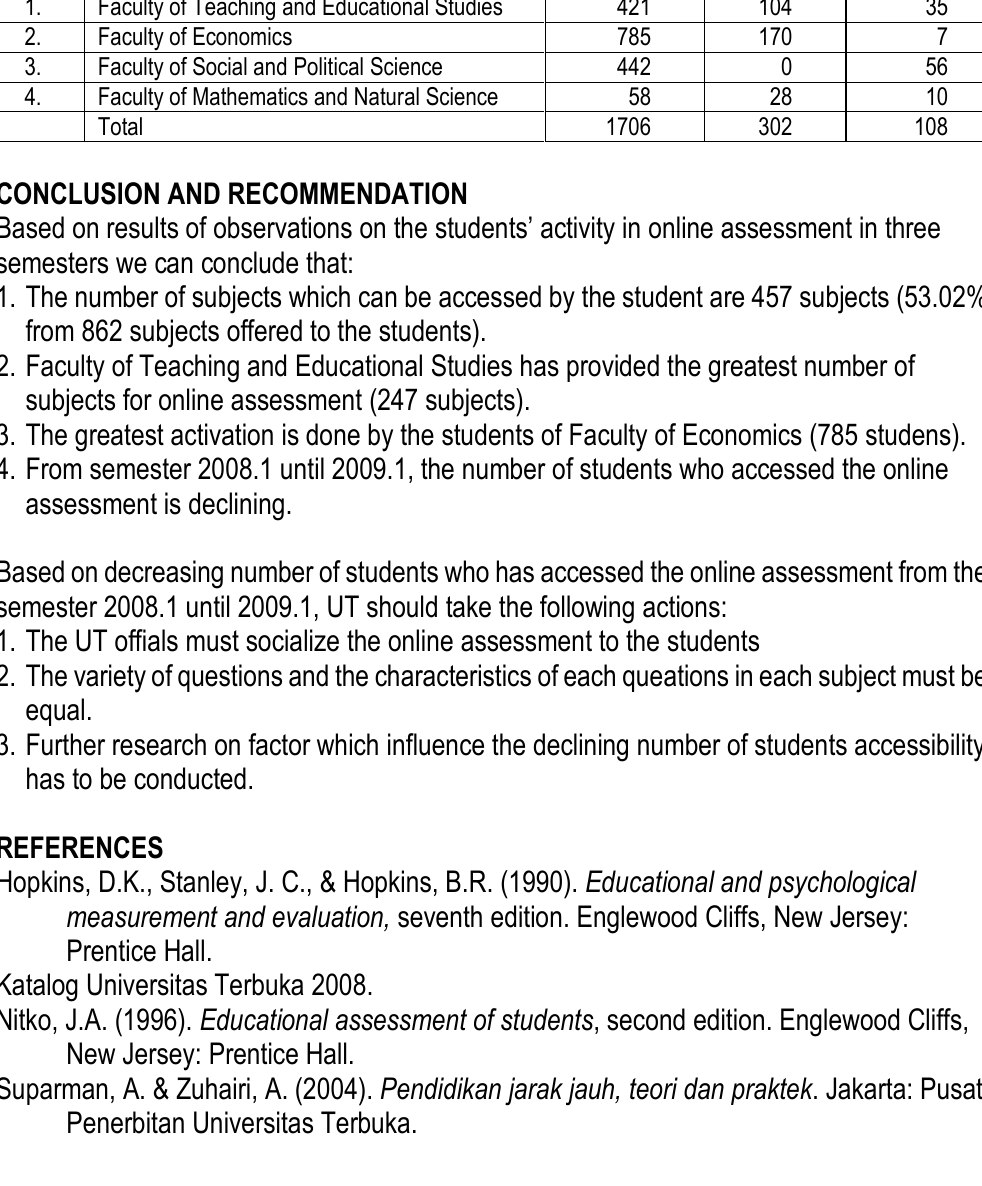
Table 3. The number of student activities, access to the online assessment in each faculty